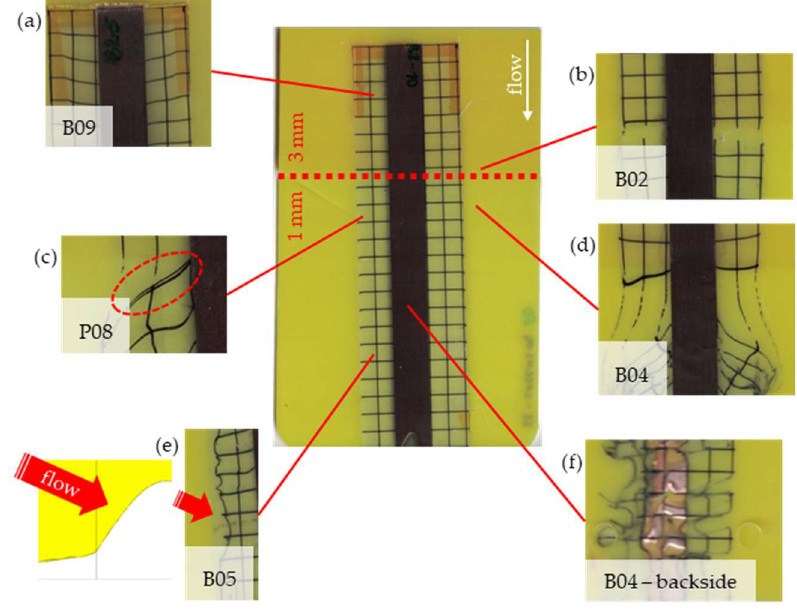
Figure 7. Overview of observed defects in regions ( a – f ). The red, dashed line indicates where the mold thickness changes from 3 to 1 mm.